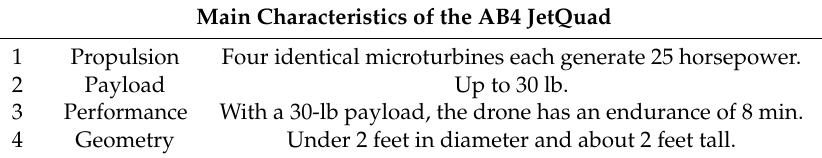
Table 1. JetQuad